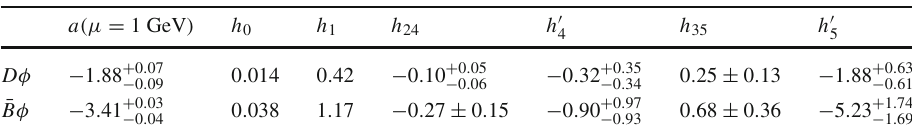
, β B and α 2 , i 1 2